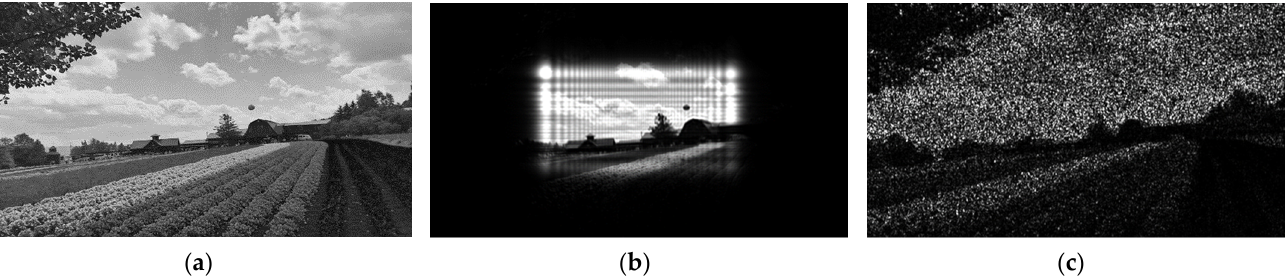
Figure 1. Original and simulated reconstructed images: ( a ) original image, ( b ) reconstructed image without random phase, ( c ) reconstructed image with random phase.